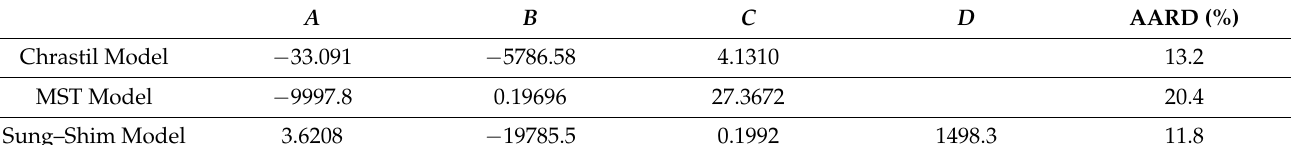
Table 2. Coefficients of the model parameters and absolute arithmetic relative deviations of the solubility data.